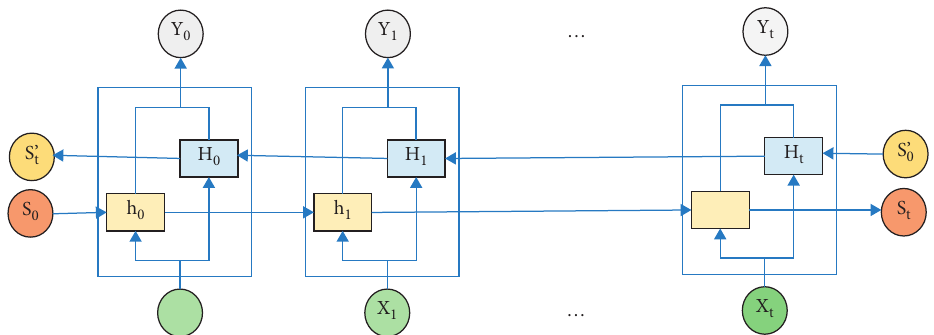
Figure 3: Specific derivation principle of BiLSTM.